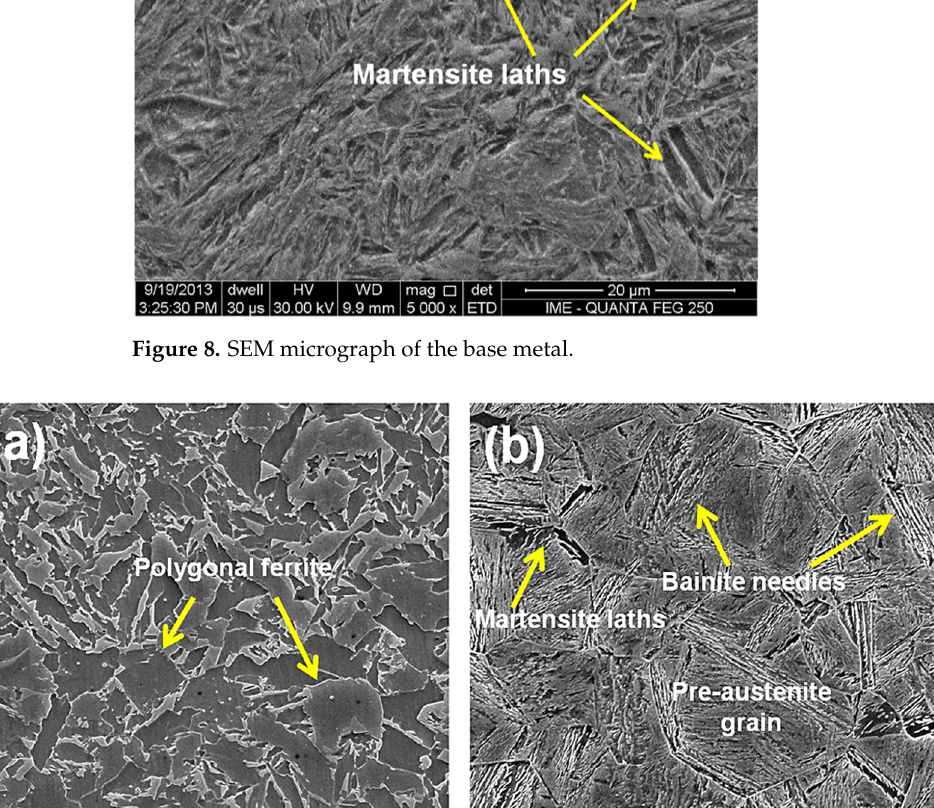
Figure 8 . SEM micrograph of the base metal.